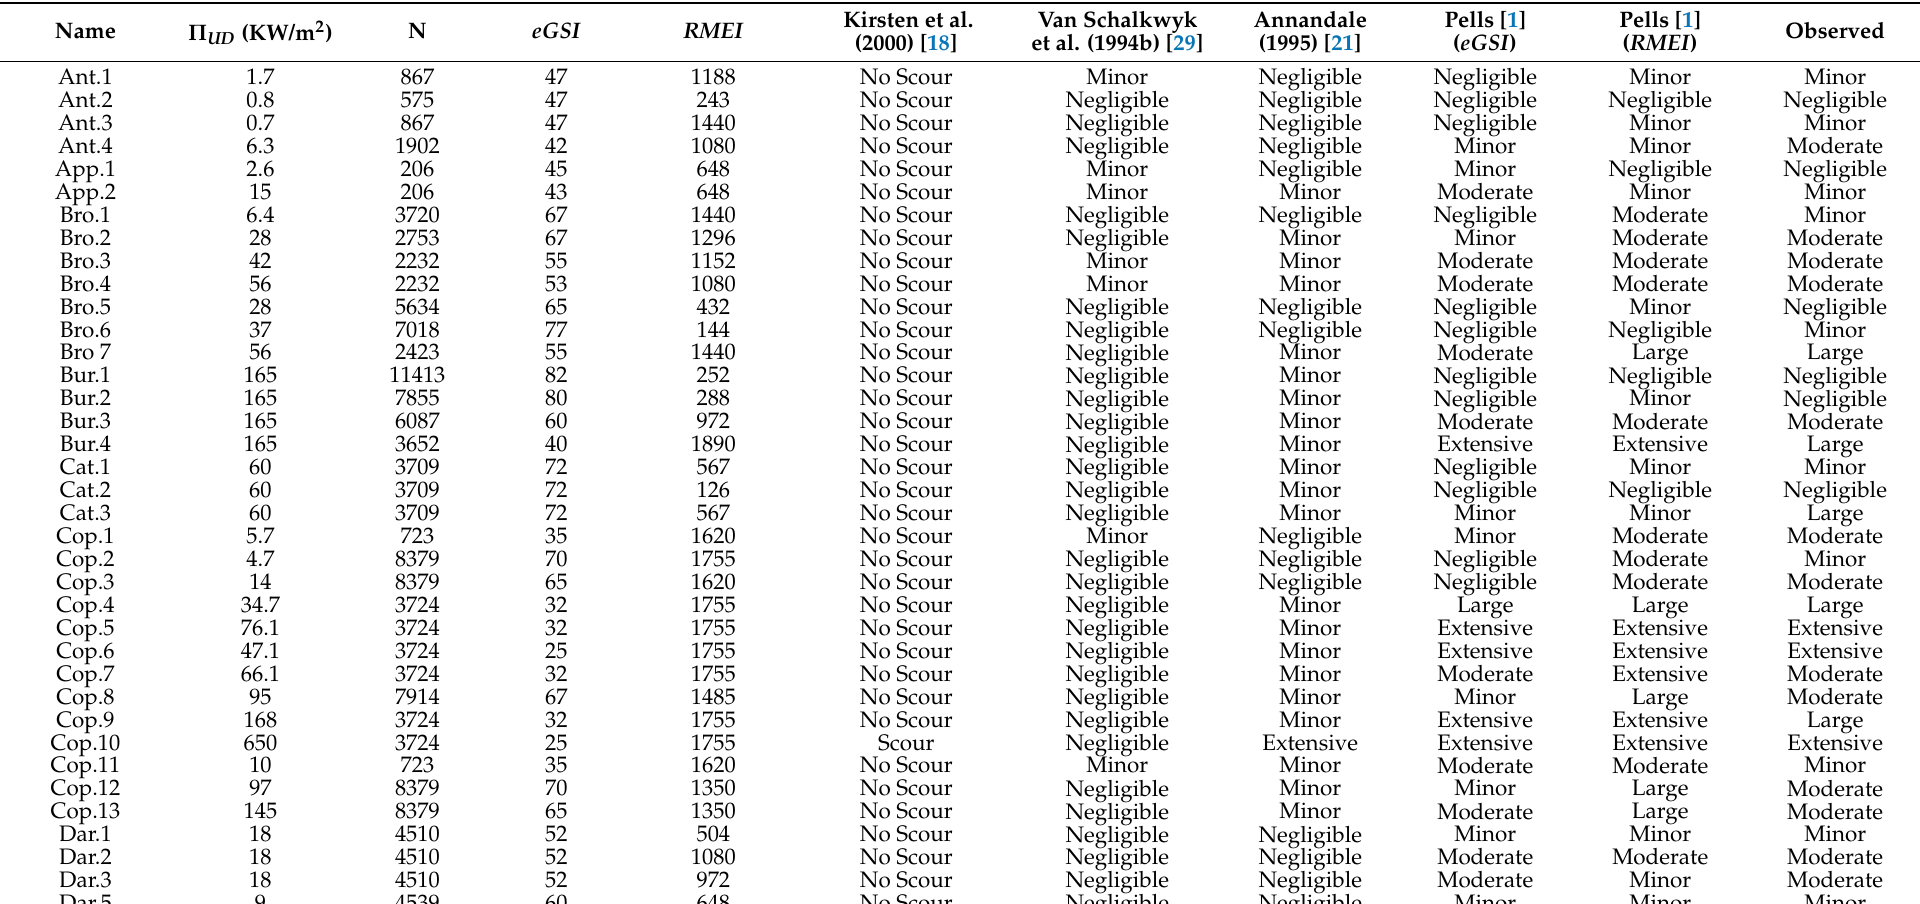
Table A1. Result of the application of various semi-theoretical approaches on several case